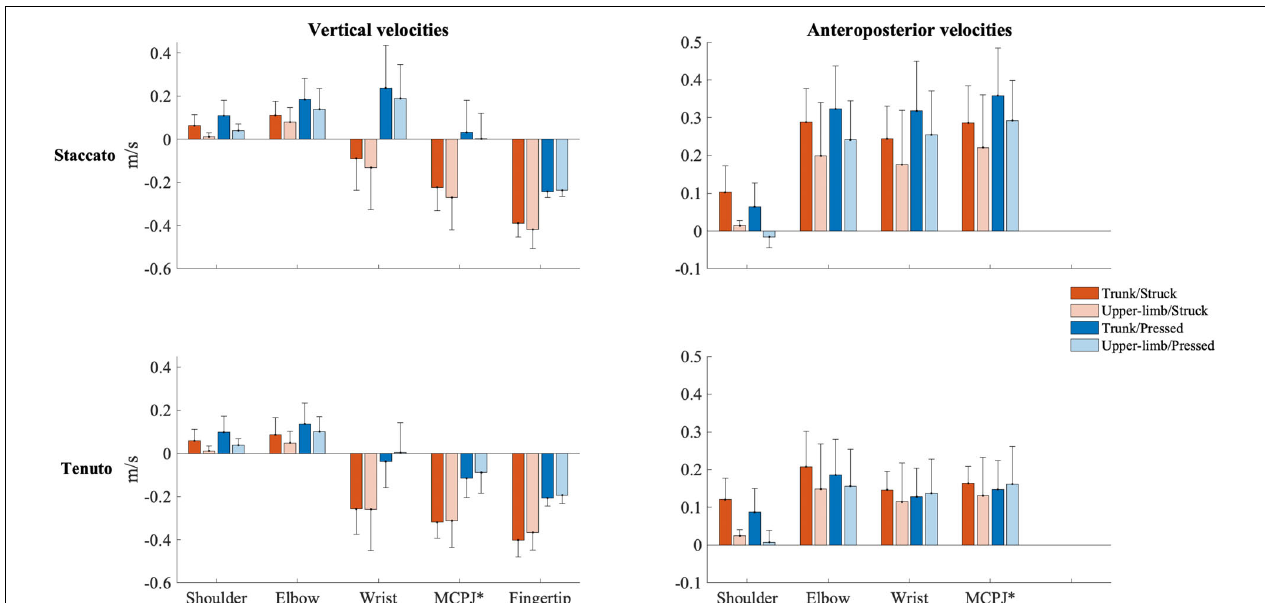
FIGURE 2 | Mean upper-limb linear velocities at the sound production time-point. Error bars indicate ± 1 standard deviation. Negative/positive values indicate downward/upward velocities and backward/forward velocities. *Metacarpophalangeal joint. TABLE 1 | Mean ± standard deviation values of upper-limb linear velocities (m/s) at the sound production time-point. Vertical velocity Anteroposterior velocity Trunk